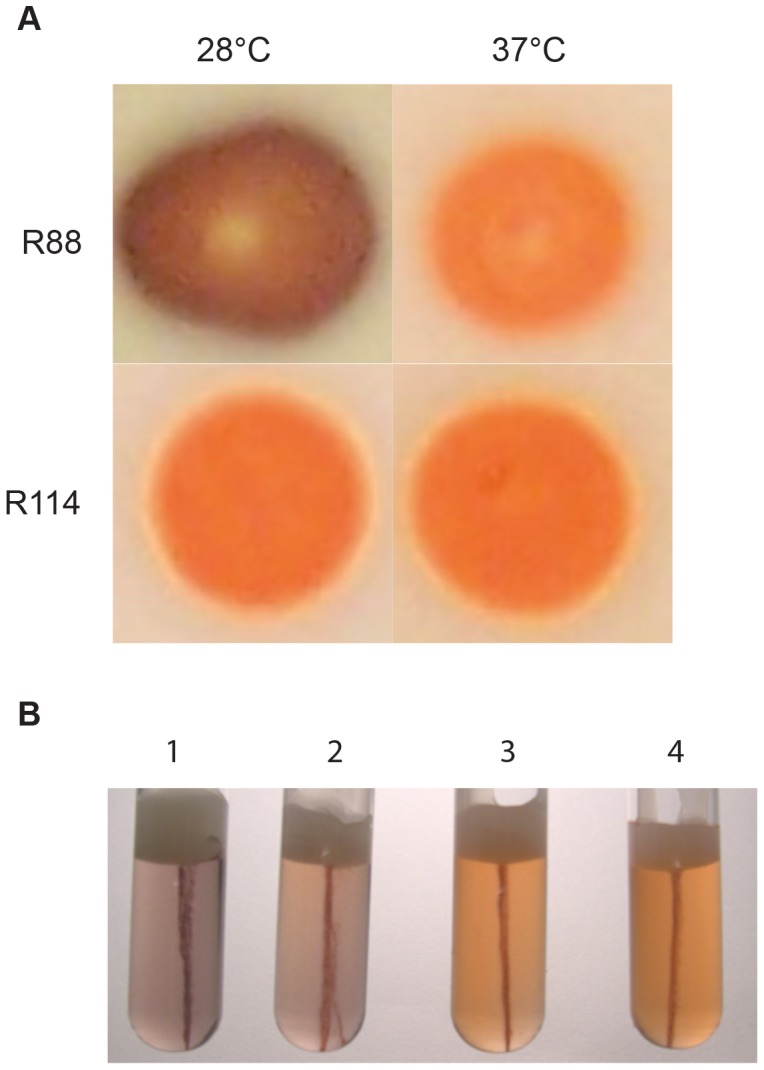
Quorum-sensing regulates fermentation of sugars.(A) Colony phenotype after 96 hrs growth on LB plates containing Congo red and 0.2% maltose and incubated at the temperature indicated. Y. pestis ferments maltose to acid, converting the Congo red to black, whereas a yspIR ypeIR mutant does not. This fermentation does not occur at temperatures above 30°C, or on other sugars tested (data not shown.) (B) Duplicate growth stabs of Y. pestis grown on solid medium under anaerobic conditions for 96 h at 28°C. An indicator dye, Congo Red, turns dark upon production of fermentative end products. Deletion of yspIR and ypeIR in R114 and R115 results in a lag in fermentation of maltose under anaerobic conditions. 1 = Y. pseudotuberculosis; 2 = R88; 3 = R114; 4 = R115.